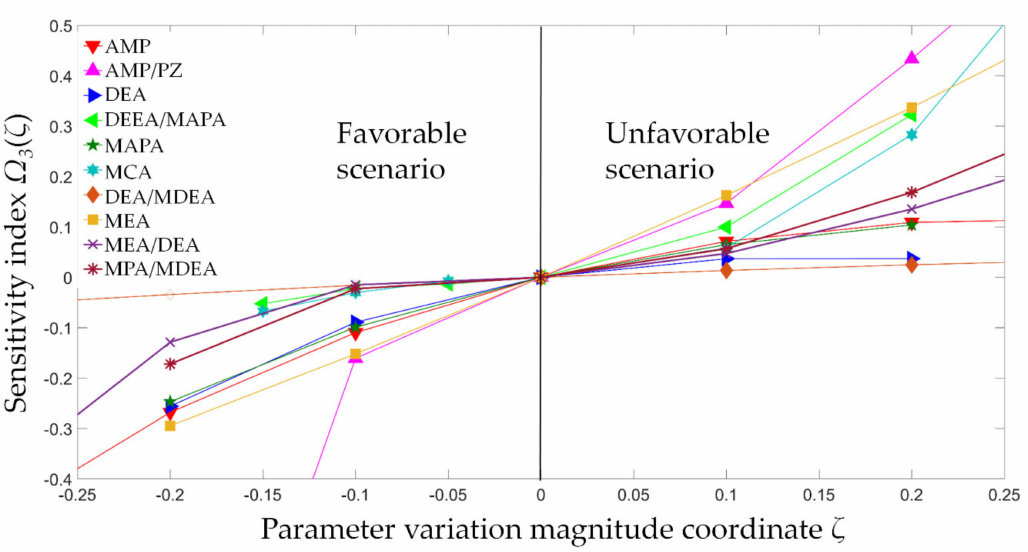
Figure 5. Sensitivity index Ω 3 ( ζ ) versus the parametric variation magnitude coordinate ζ